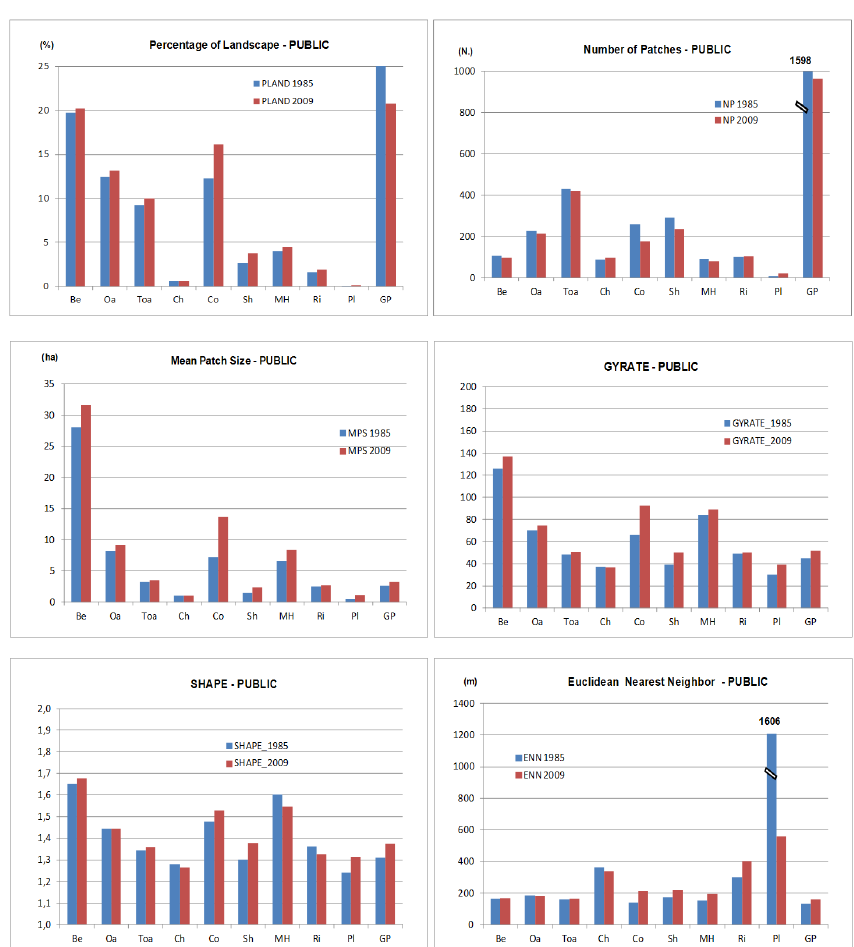
Figure 9. Histograms of the used metrics at class level for public-ownership natural covers for the complex ecomosaics (1985–2009). For further details on landscape indicators see Table